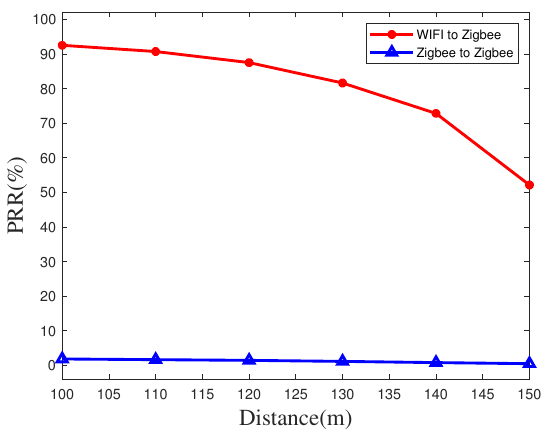
Figure 9. Packet reception rate at long distance on the